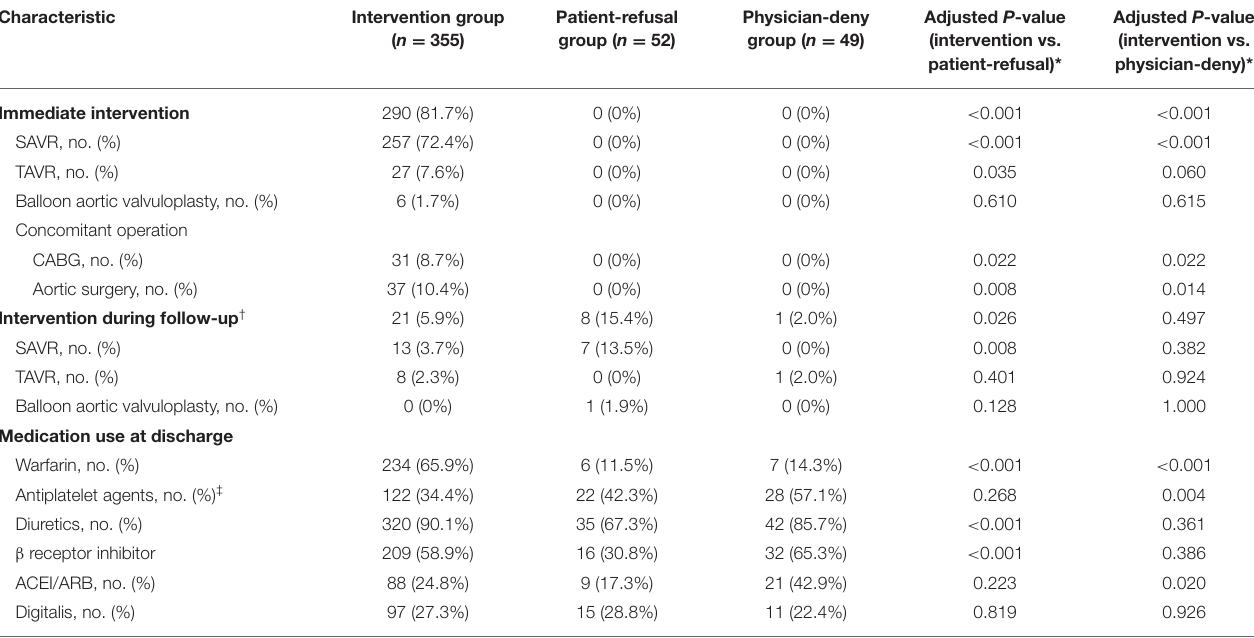
TABLE 2 | Intervention and medication use. Characteristic Intervention group